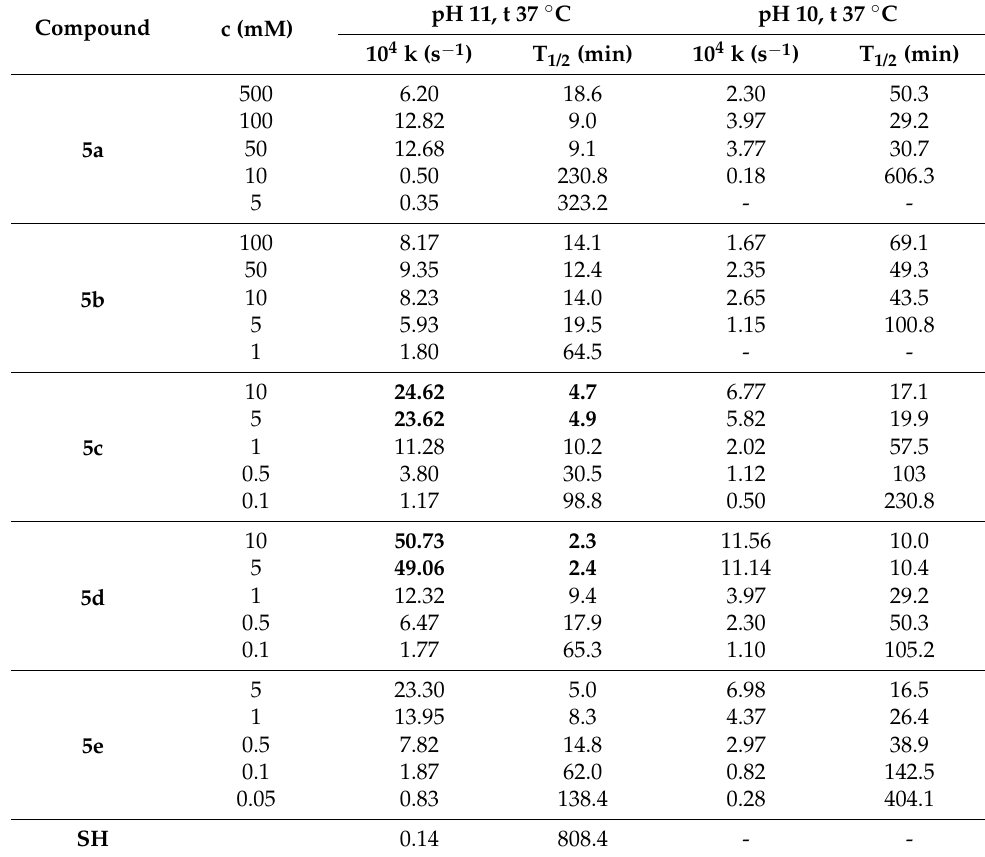
Table 3. Summary data of fenitrothion